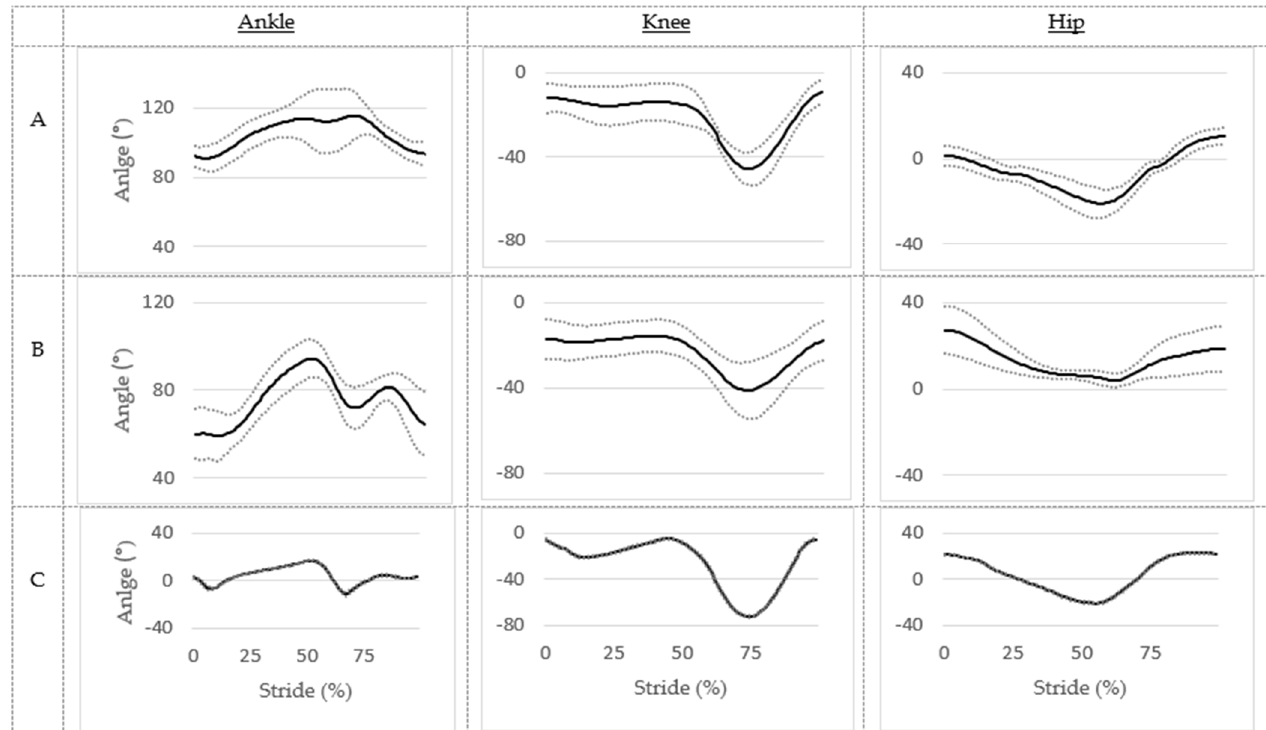
Figure 8. Ensemble averaged leg angles measured for participant one. Row A is with the person facing the camera array. Row B is with the person facing away from the camera array. Row C provides normative reference data from a typical 3D motion-analysis system [34]. Grey dotted lines are the one-standard-deviation upper and lower bounds.